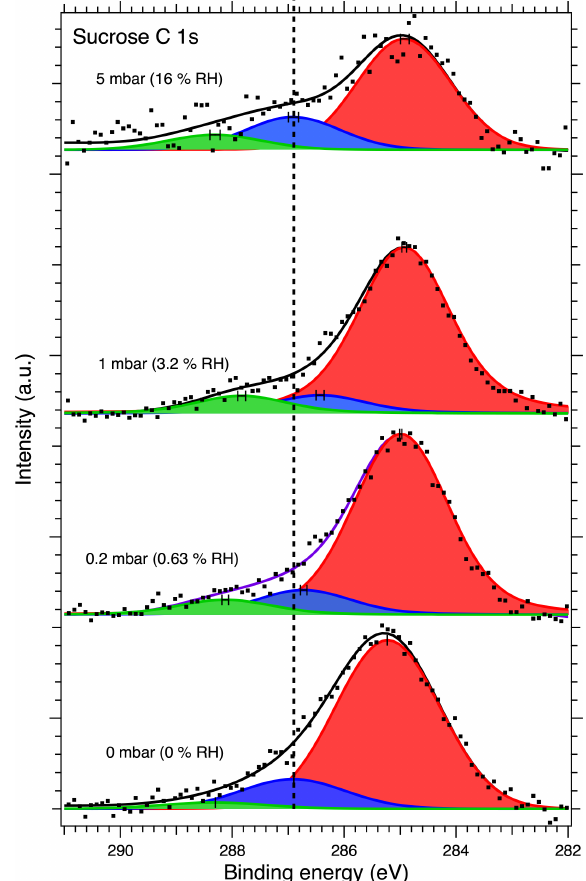
Figure 5. C 1s XPS spectra of sucrose aerosol particles. The dots show the recorded data, the solid lines the fit envelope curve, and the red, blue and green peaks the C–C / C–H, C–O and O–C–O car- bon components, respectively. The dashed vertical line shows the binding energy of the C–O component at 0mbar pressure (0% RH) at the beginning of the experiments. Error bars show the estimated uncertainty in the peak position from Monte Carlo analysis. Photon energy was 1253.6eV from the Mg